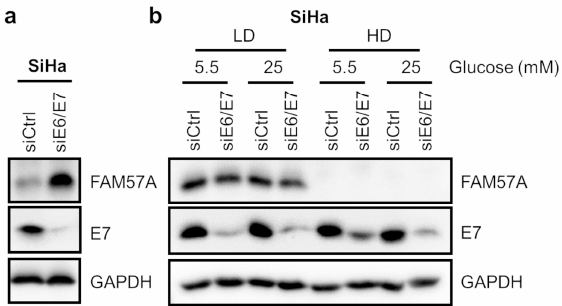
Figure 4. FAM57A expression after HPV E6/E7 oncogene repression. ( a ) Immunoblot analyses of FAM57A and HPV16 E7 protein levels in SiHa cells after siRNA-mediated E6/E7 silencing (siE6/E7). siCtrl, control siRNA; GAPDH, representative loading control. ( b ) Immunoblot analyses of FAM57A and HPV16 E7 protein levels in SiHa cells seeded at LD or HD after siRNA-mediated E6/E7 silencing (siE6/E7), and subsequent cultivation under 5.5 mM or 25 mM glucose for 24 h. siCtrl, control siRNA; GAPDH, representative loading control.